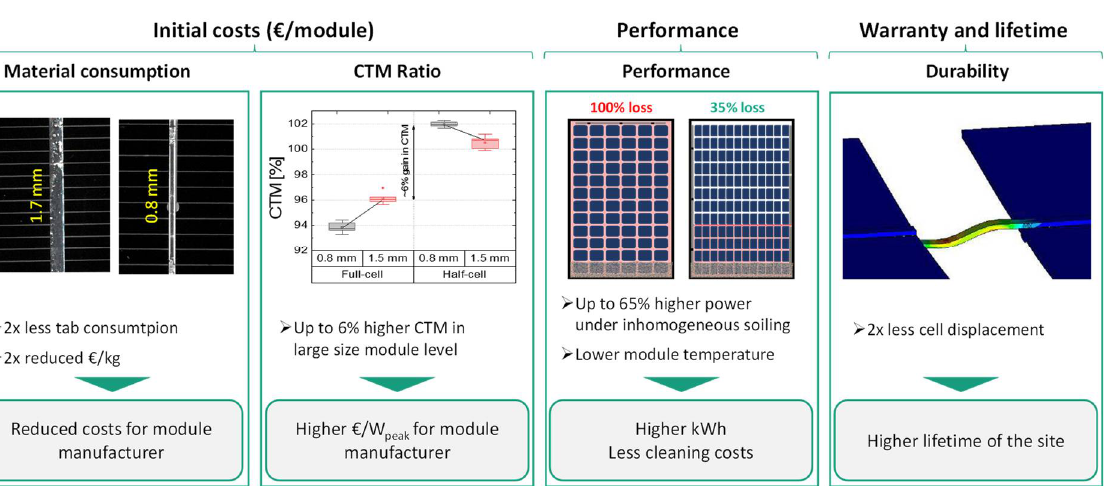
Figure 17. ( left ) Comparison of component costs for half-cell and full-cell modules with five-busbar solar cells and ( right ) a magnification of the left diagram between 65 and 70 EUR/module to highlight the difference in components’ costs between the modules.